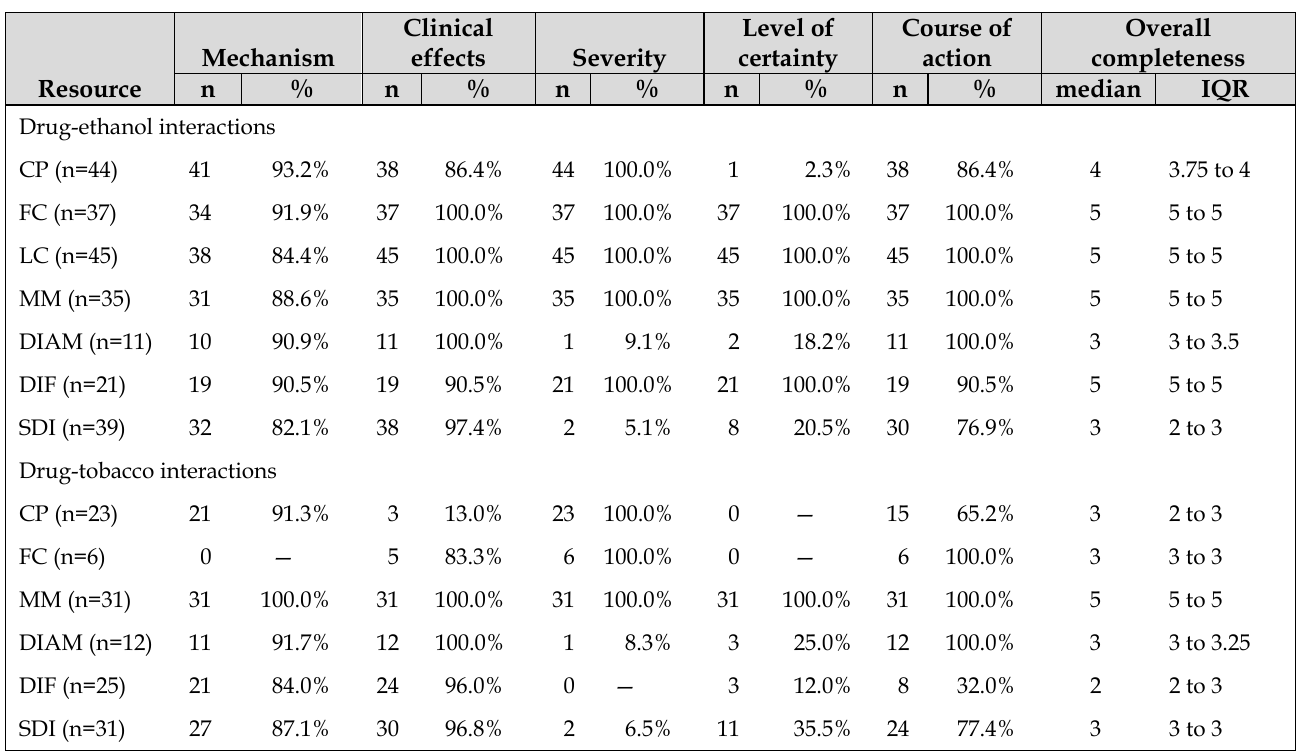
Table 3 Completeness results for interactions with